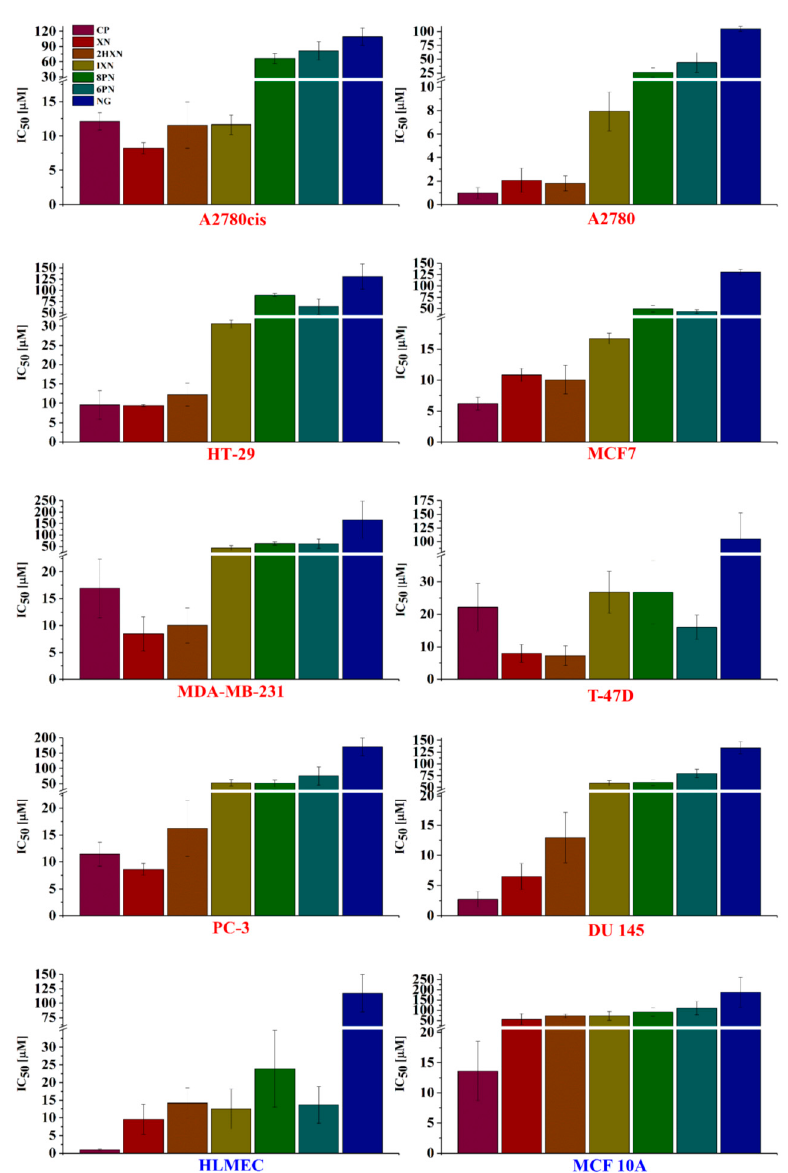
Figure 2. Antiproliferative activity of tested flavonoids and cisplatin against human cancer cell lines (marked red) and normal ones (marked blue).